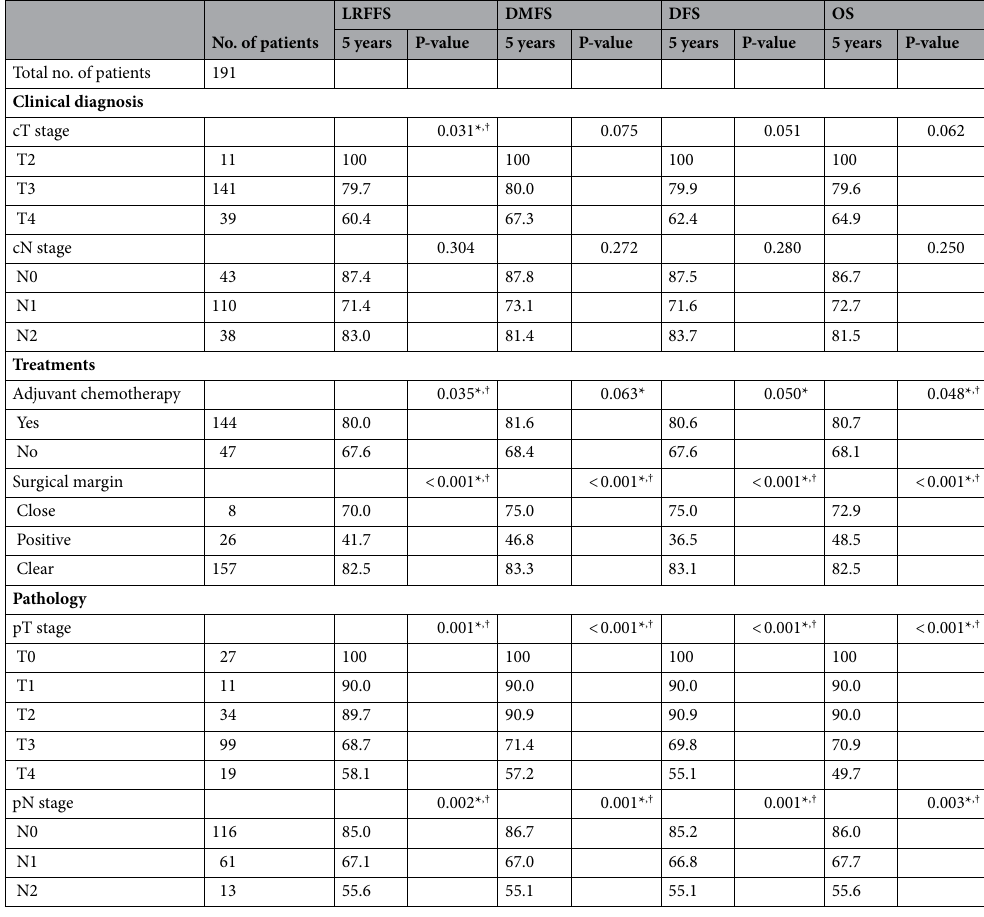
Table 2. Baseline survival characteristics of the patients. * P < 0.1, † P < 0.05. The 5-years survivals are expressed as percentage. The P- values are calculated from the log-rank test of the stratified Kaplan–Meier